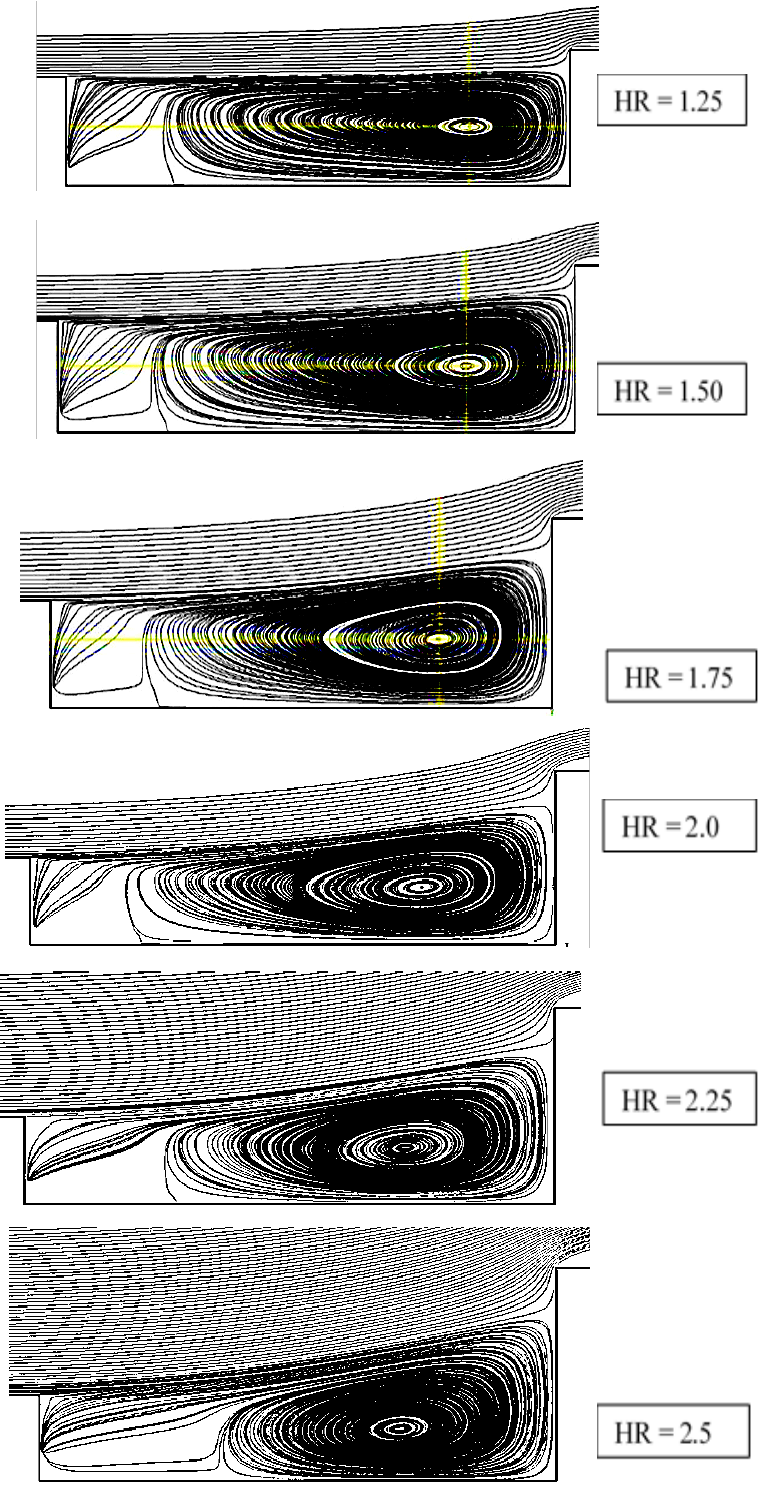
Figure 7. Streamlines inside the shallow cavity with (AR = 5) at different height ratios (1.25 ≤ HR ≤ 2.5).